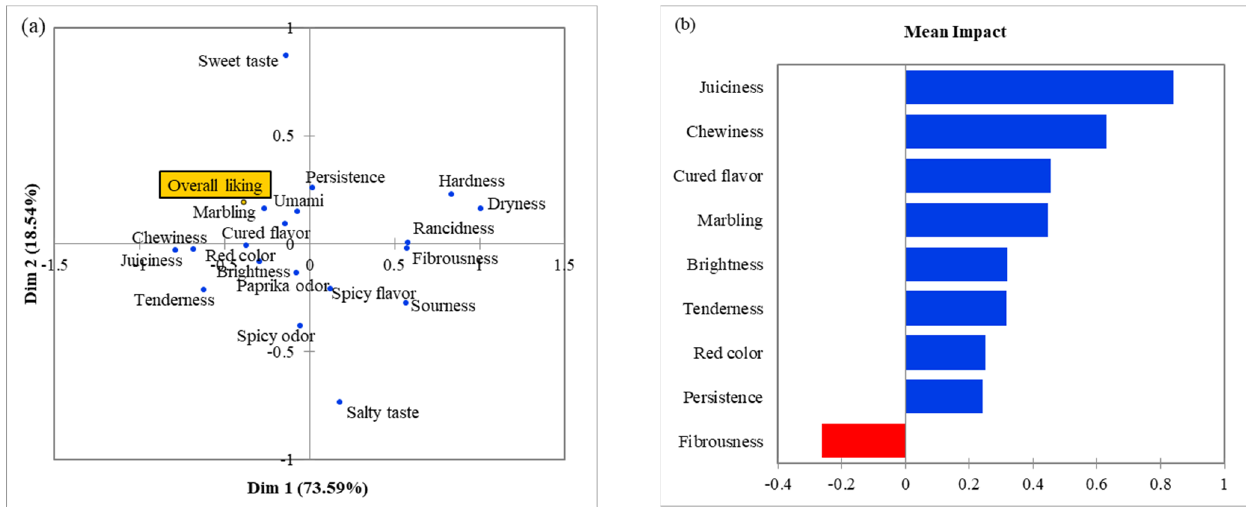
Figure 2. Principal Coordinate Analysis (PCoA) plot ( a ) of CATA term frequencies and overall liking scores for the dry-cured loin samples: green label—GL (Cebo de Campo Ibérico), red label—RL (Bellota 50% Ibérico), black label—BL (Bellota 100%), and liking mean impact plot ( b ) displaying in blue attributes identified as ‘drivers of liking’ and in red the ‘drivers of disliking’ attributes.